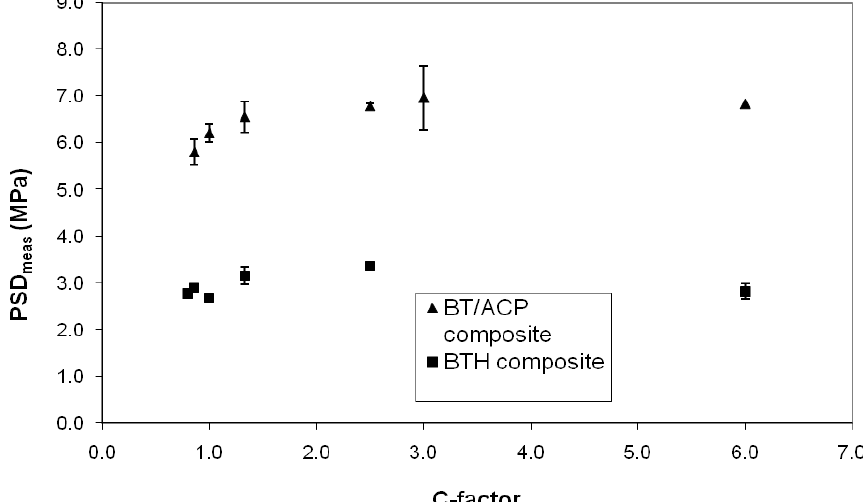
Figure 4. Functional dependence of PSD PSD values calculated from the mean PSD calc